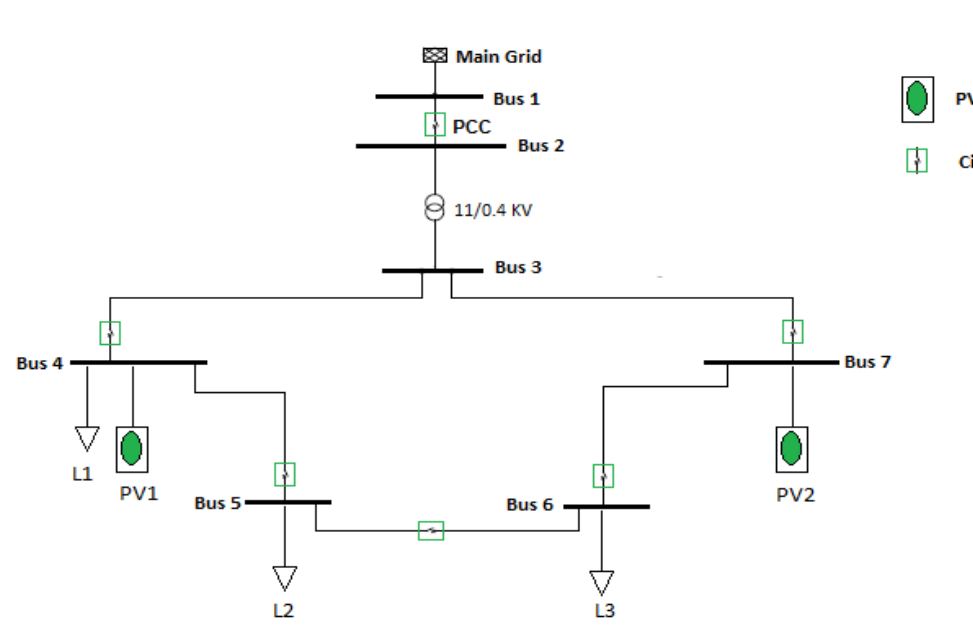
Figure 3. Ring topology of MG 2.